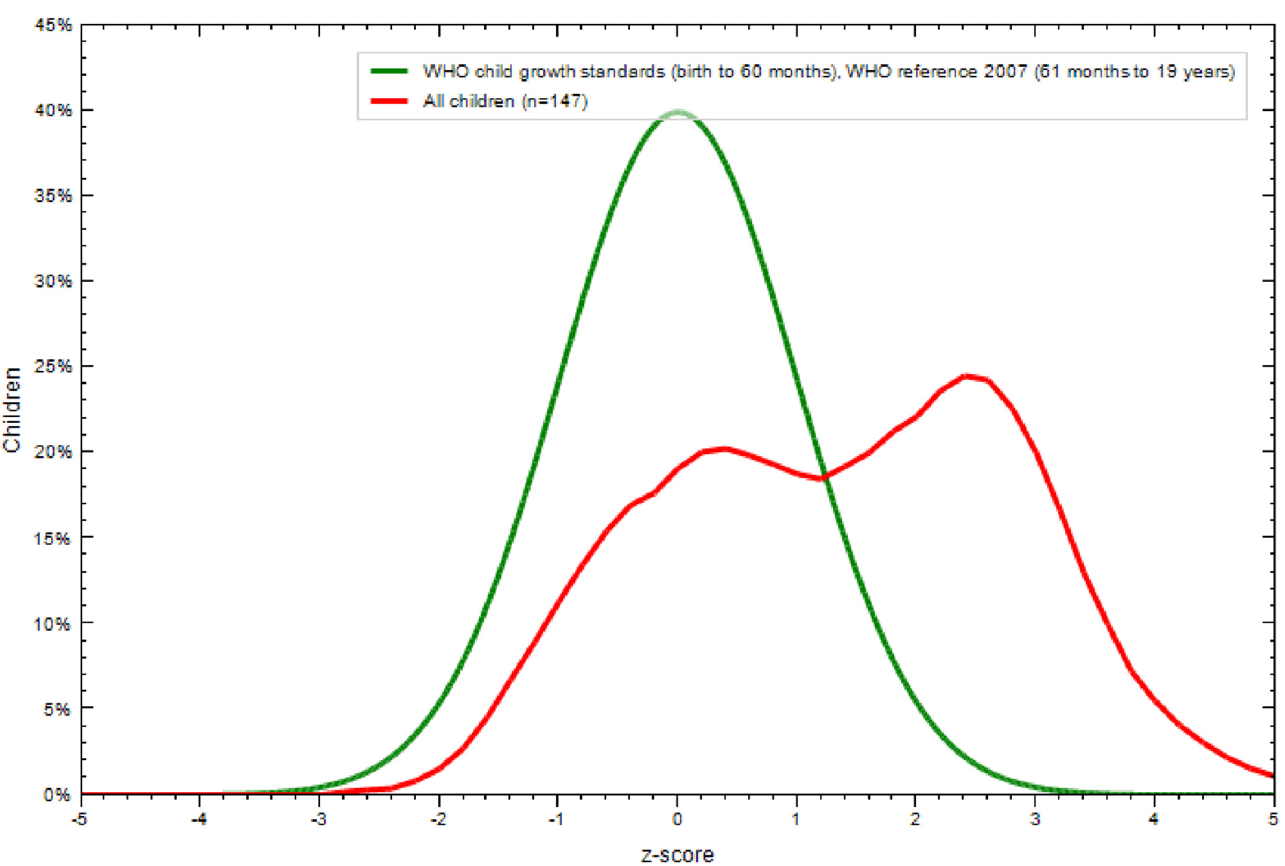
Figure 2. BMIZ score of the study sample compared to the 2007 WHO reference population. BMIZ of the study sample is depicted in red and that of the reference sample in green. BMIZ: Body mass index Z score; X-axis: BMIZ score; Y-axis: percentage. Two children had BMIZ scores >5 and are not represented in the figure.